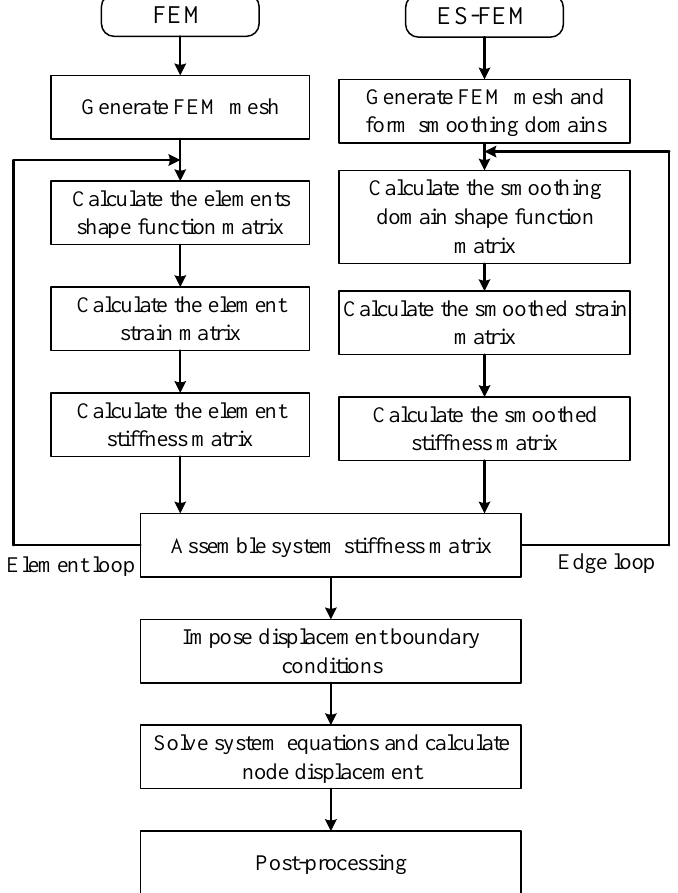
Figure 1. Flow chart of the FEM and